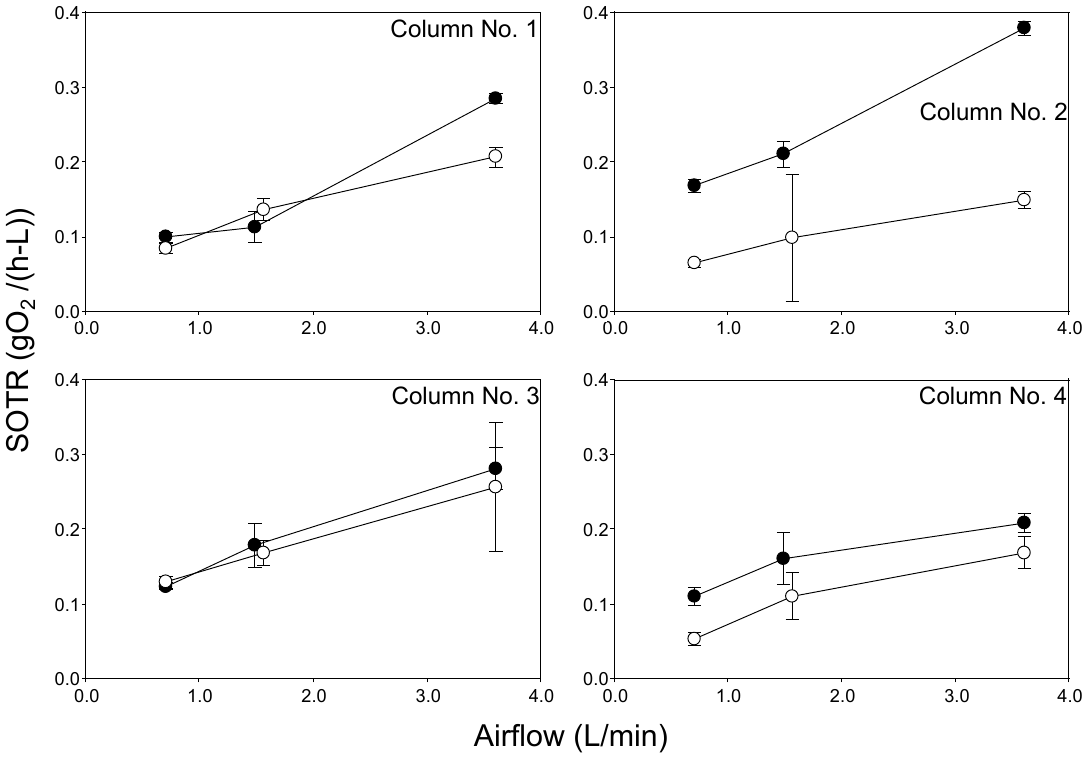
Figure 3. Specific oxygen transfer rate (SOTR) by liter in each location: ( ) location 1, Universidad Católica de Maule (Talca, Chile); ( ) location 2, Universidad Militar Nueva Granada (Cajicá, Colombia).